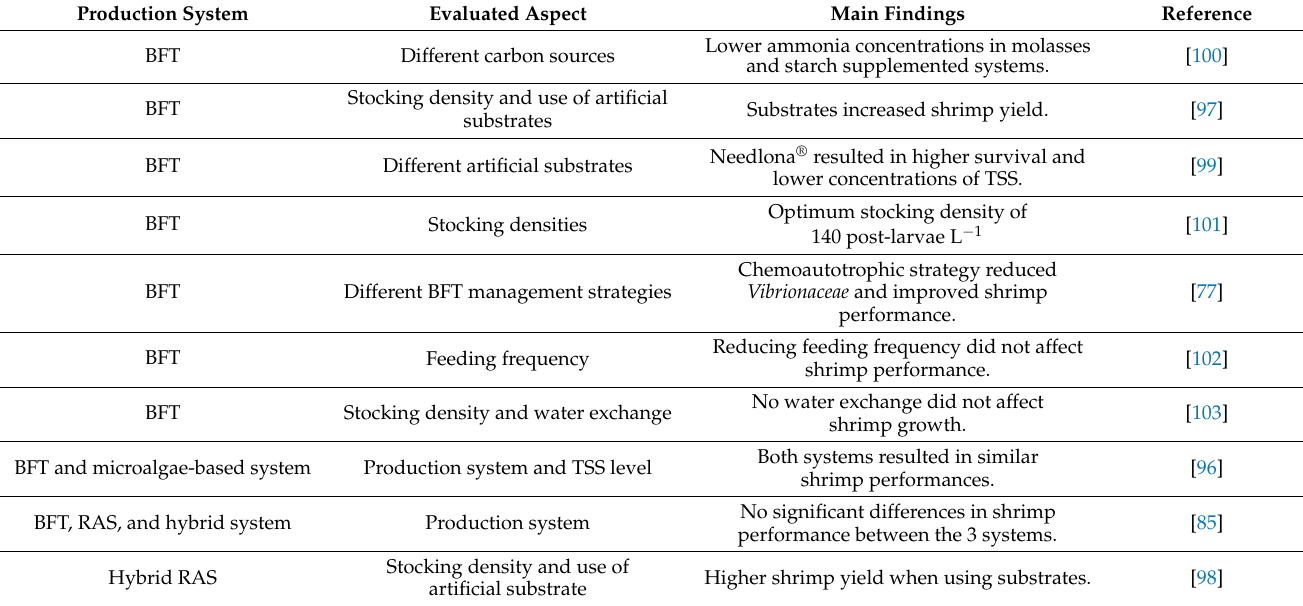
Table 3. Summary of recent studies evaluating different aspects of L. vannamei nursery systems. Production